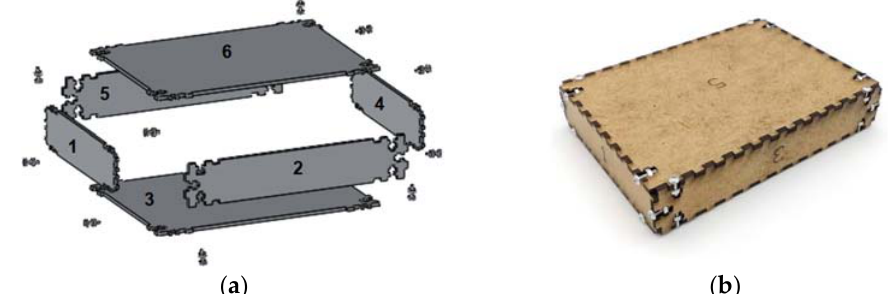
Figure 5. The object that is used for assembly process [64]. On the right ( a ) the box parts and on the left ( b ) fully assembled box.